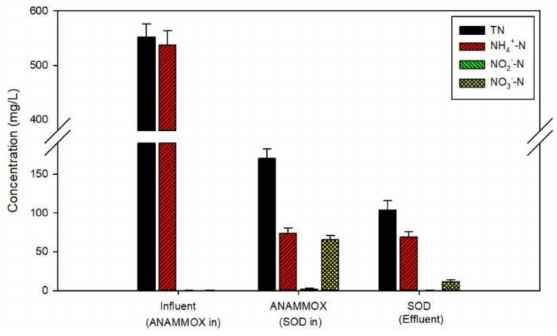
Figure 6. Nitrogen removal profile for the whole (Anammox+SOD)